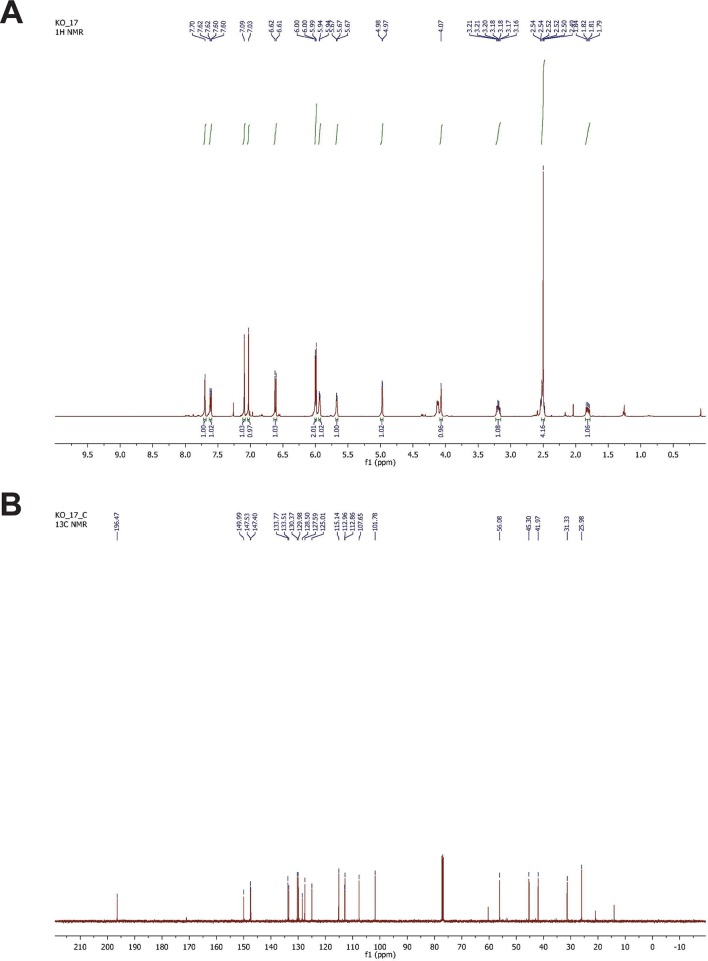
NMR spectrometry of synthesized G-1.(A) H-NMR spectrometry of synthesized G-1. 1H-NMR (500 MHz, CDCl3) δ 7.70 (s, 1H), 7.61 (dd, J = 5.0, 2.5 Hz, 1H), 7.09 (s, 1H), 7.01 (s, 1H), 6.61 (d, J = 8.5 Hz, 1H), 5.99 (d, J = 6.0 Hz, 2H), 5.93 (m, 1H), 5.67 (d, J = 4.5 Hz, 1H), 4.97 (d, J = 3.0 Hz, 1H), 4.12 (d, J = 9.0 Hz, 1H), 3.19 (q, J = 8.5 Hz, 1H), 2.54–2.48 (m, 4H), 1.84–1.79 (m, 1H). (B) 13C-NMR spectrometry of G-1. 13C-NMR (125 MHz, CDCl3) δ 196.5, 150.0, 147.5, 147.4, 133.8, 133.5, 130.4, 130.0, 128.5, 127.6, 125.0, 115.1, 112.9, 112.8, 107.6, 101.8, 56.1, 45.3, 42.0, 31.3, 26.0.